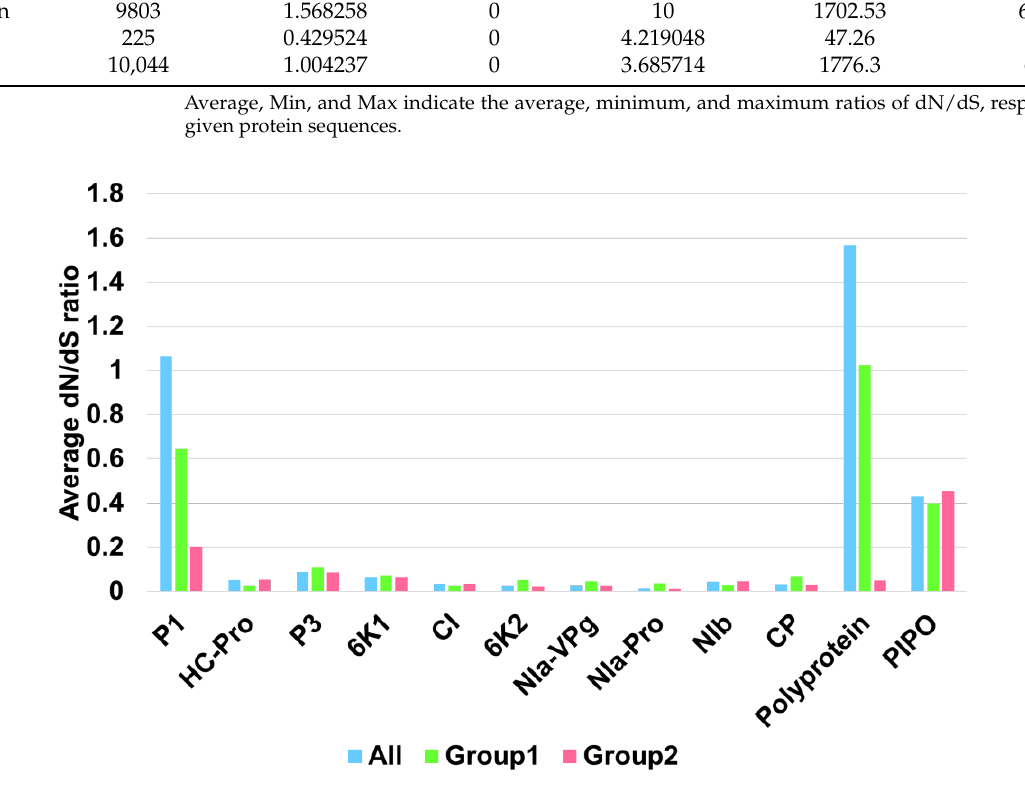
Figure 8. Average dN/dS ratio of SMV proteins in three groups. ‘All’ indicates the 143 SMV genomes, whereas group 1 and group 2 include 6 and 137 SMV genomes, respectively.